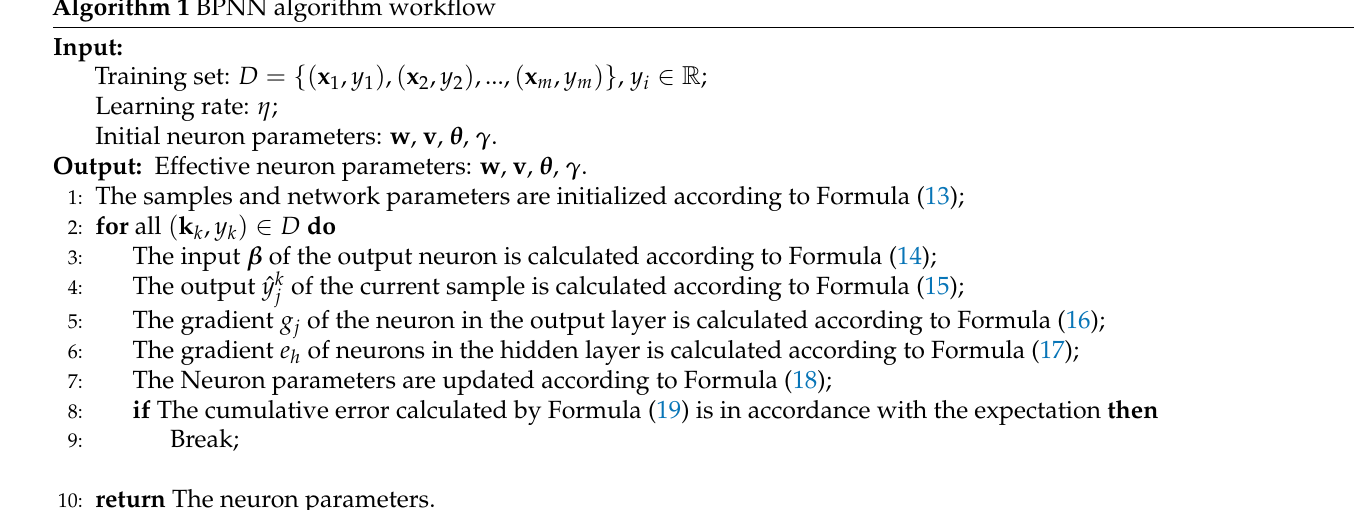
Algorithm 1 BPNN algorithm